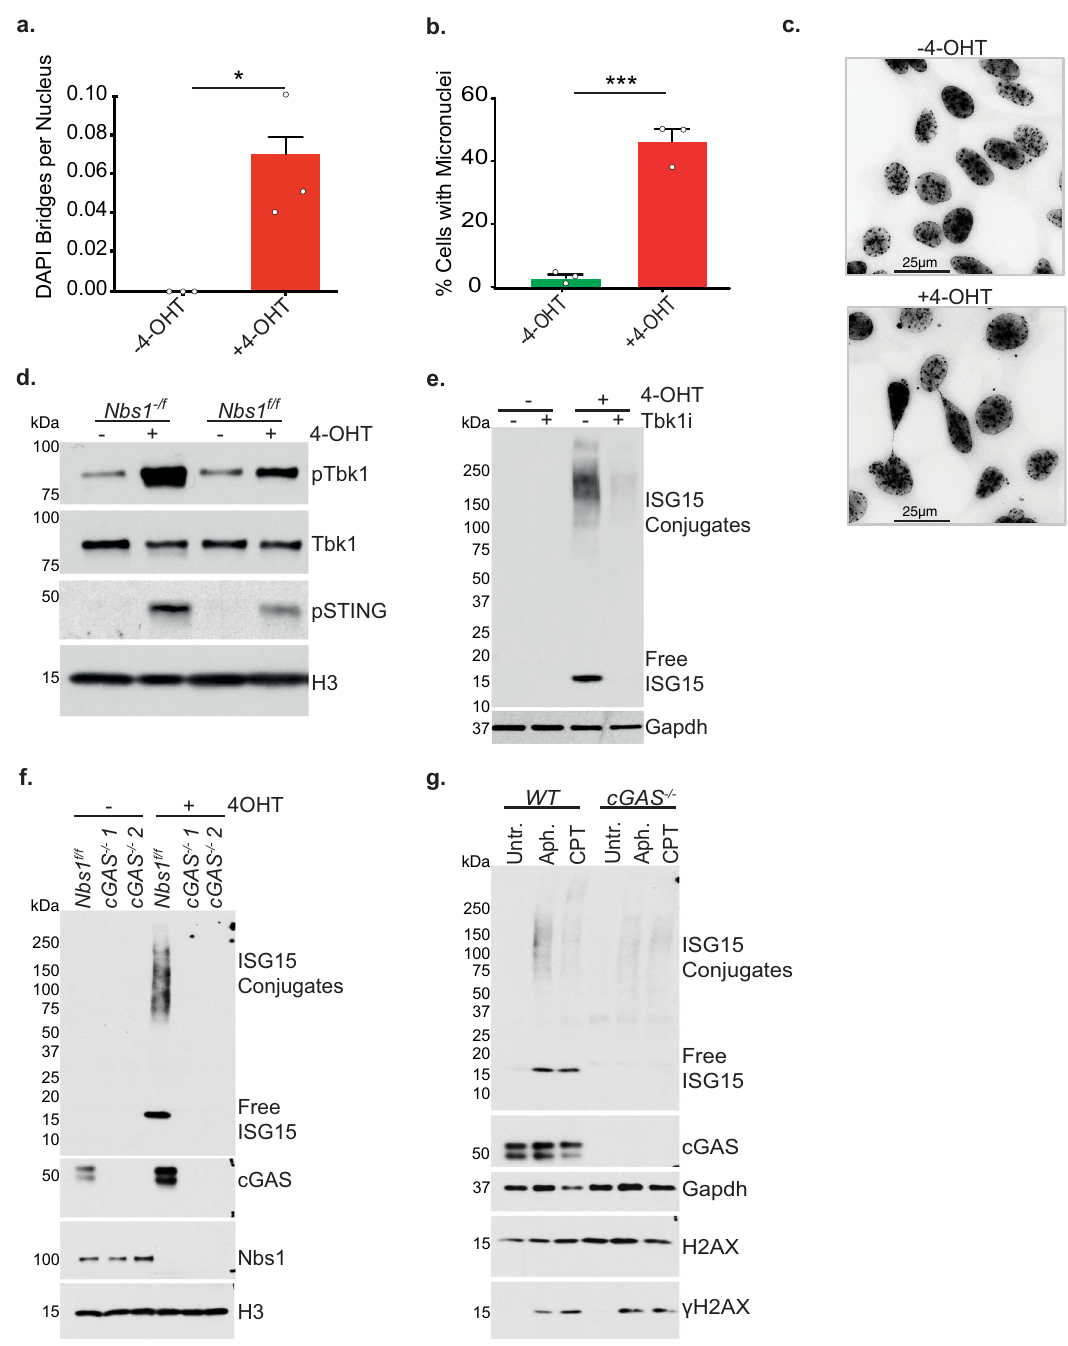
Fig. 3| CytoplasmicDNA underliesISG15inductionUpon Nbs1 Deletion.a DAPI stained DNA bridges per nucleus for Nbs1 f/f MEFs three days post 4-OHT addition. Mean of three independent experiments with SEM. Two-tailed unpaired t -test was used. * = p 0.0270. b The percentage of Nbs1 f/f MEFs 3 days post 4-OHT addition cells with micronuclei. Mean of three independent experiments with SEM. Two- tailedunpaired t -testwasused.***= p 0.0005 c Exampleimagesforthedatashown in a and b. Between 105 and 152 cells were counted per condition per biological repeat( − 4-OHT n =371,+4-OHT n =416). d Westernblotofwholecellextractsfrom